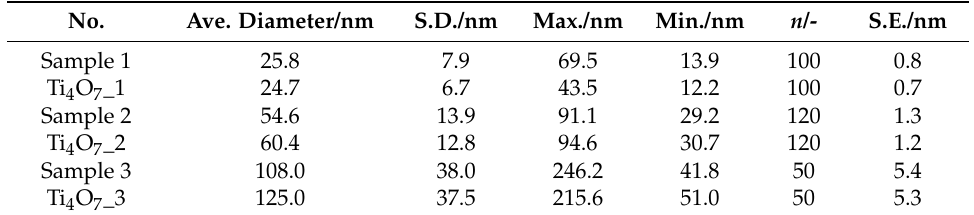
Figure 6. Histograms of nanoparticle size of pristine and synthesized Ti 4 O 7 . Table 4. Average particle size (Ave. diameter), standard deviation (S.D.), maximum particle diameter (Max.), minimum particle diameter (Min.), sample number (n), and standard error (S.E.) of pristine TiO 2 and synthesized Ti 4 O 7 .